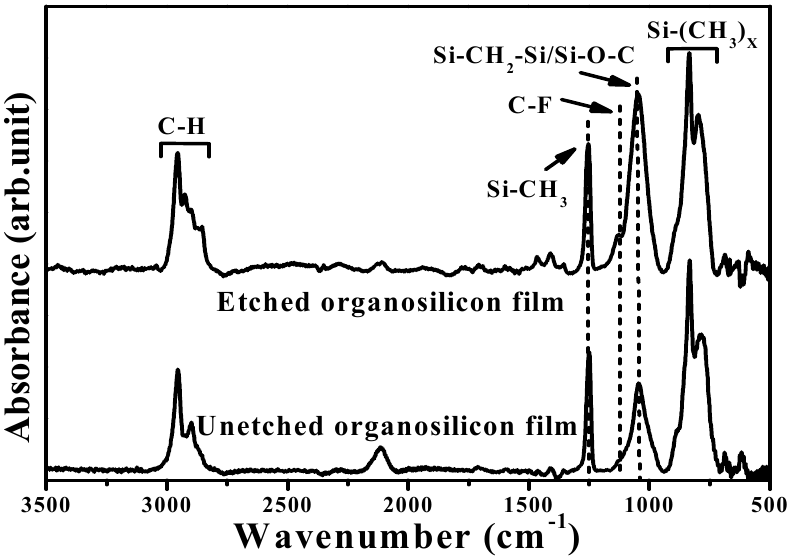
Figure 10. FTIR spectra of the organosilicon film before and after the CF 4 plasma etching for 40 s.